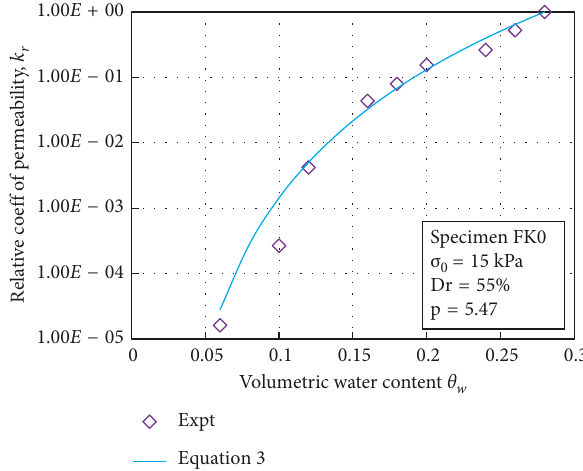
Figure 11: Permeability changes against volumetric water content for FK0 soils.